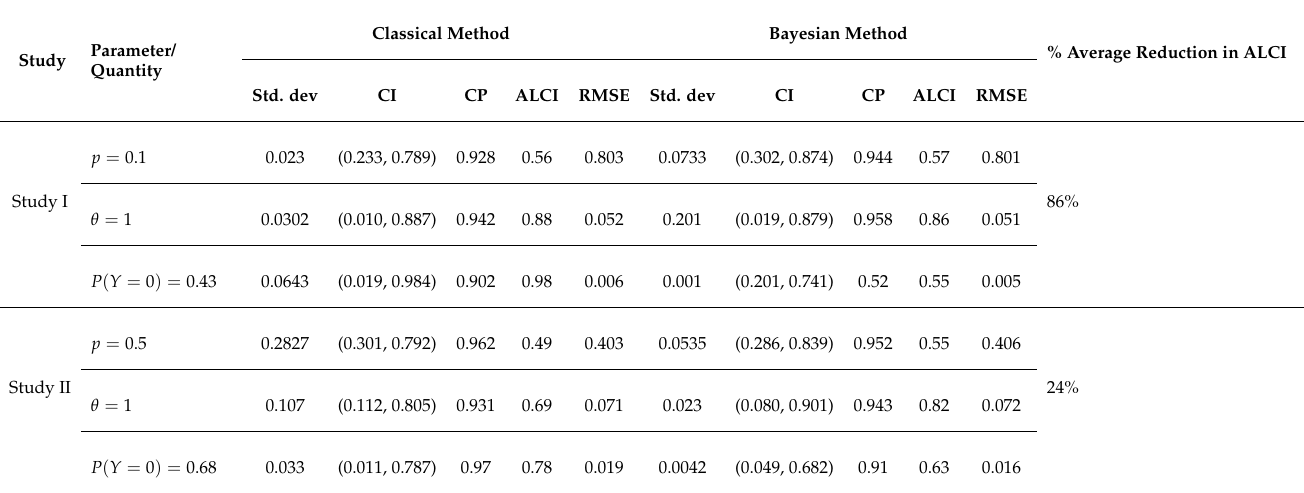
Table 1. Simulation for c.p. based on 95% C.I. and